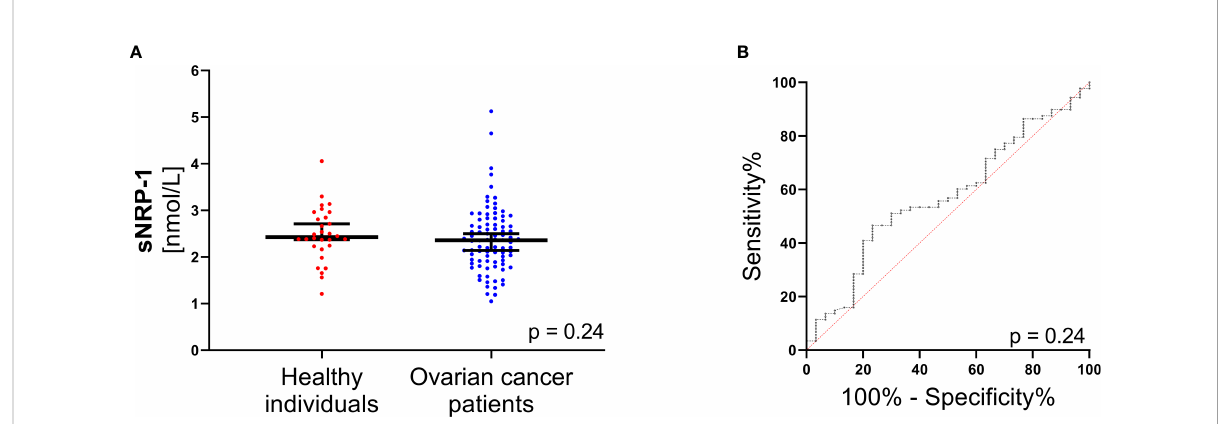
FIGURE 1 sNRP-1 levels in ovarian cancer at primary diagnosis. (A) Scatter plots comparing sNRP-1 levels in ovarian cancer patients (n = 88) and in healthy individuals (n = 30). The black horizontal lines indicate median sNRP-1 levels in each group, with error bars showing the 95%CI. P-value according to the non-parametric, two ‐ sided Mann-Whitney test. (B) Receiver operating characteristic (ROC) analysis to determine the diagnostic ability of sNRP-1 levels to distinguish between ovarian cancer patients (n = 88) and healthy controls (n = 30). The respective area under the curve (AUC) values and the 95%CIs are indicated.